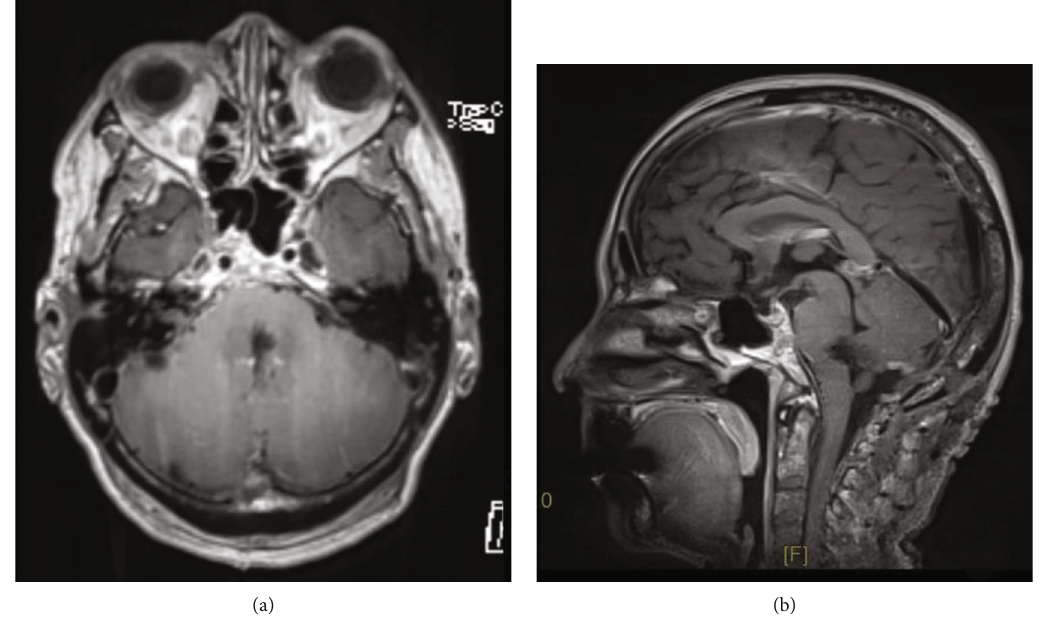
Figure 2: (a) Postoperative contrast-enhanced MRI con fi rms that the metastasis was totally removed. (b) The remaining medulla and pons tissues have fi lled the space, except for a very thin